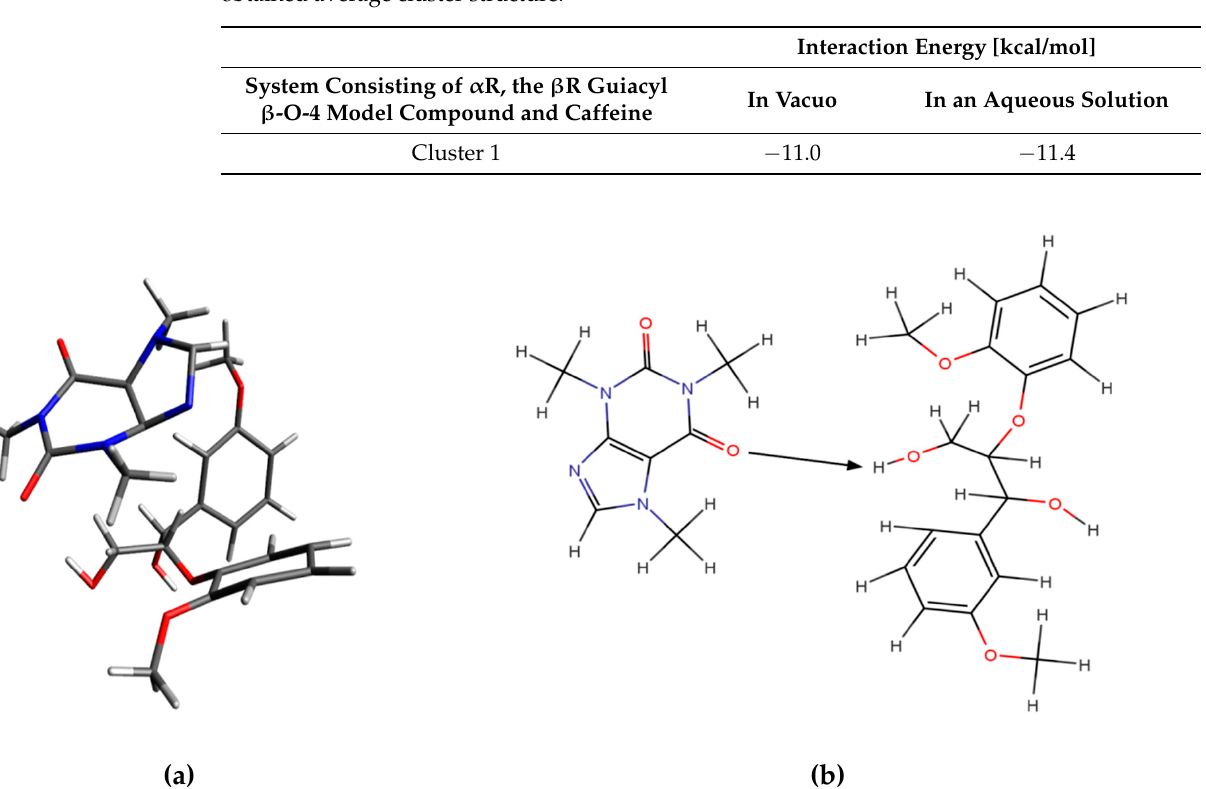
Figure 5. Structure ( a ) and scheme of the interaction ( b ) of cluster 1 in a system consisting of α R, the β R guiacyl β -O-4 model compound, and caffeine.